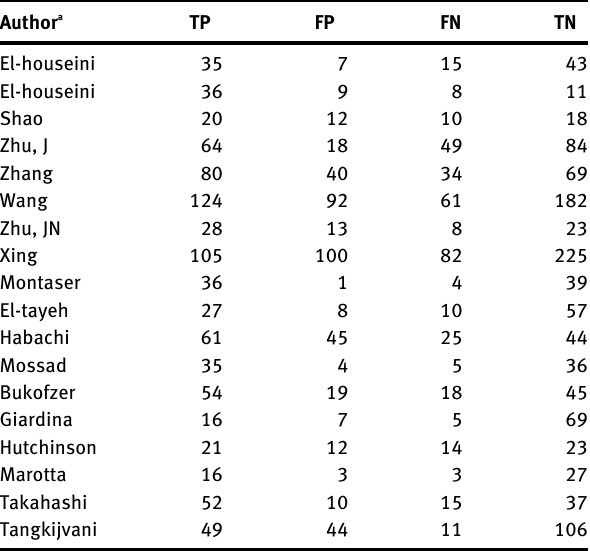
Table  : Subjects ’ raw data of the articles selected. Author